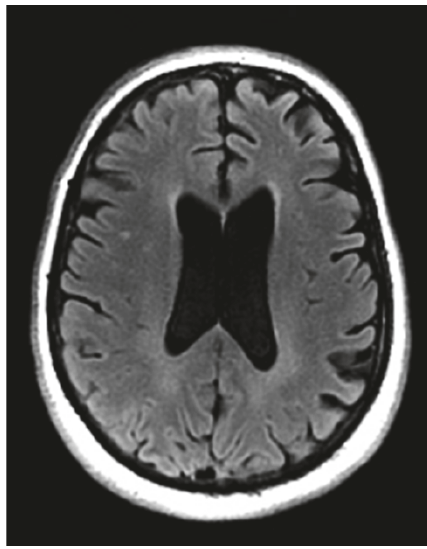
Figure 1: Patient’s MRI revealing left thalamic infarct and chronic small vessel ischemic changes.